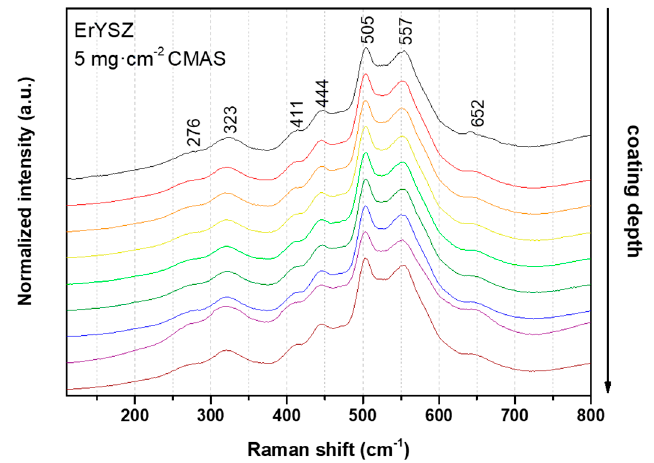
Figure 7. Raman spectra in the cross-sections of the ErYSZ coating after CMAS attack with a 5 mg·cm − 2 deposit.